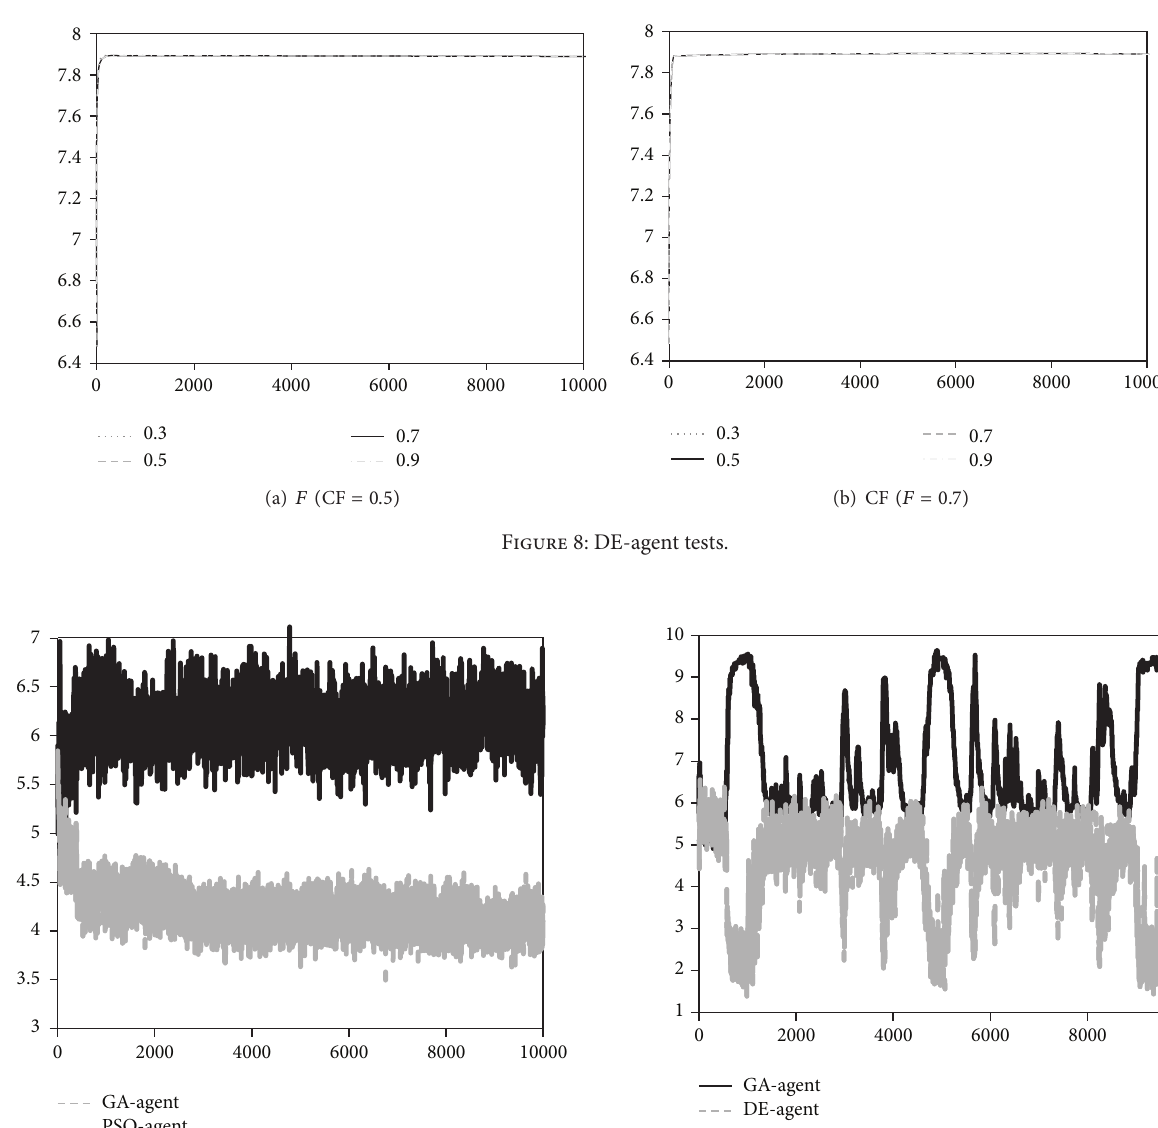
Figure 10: GA-agent versus